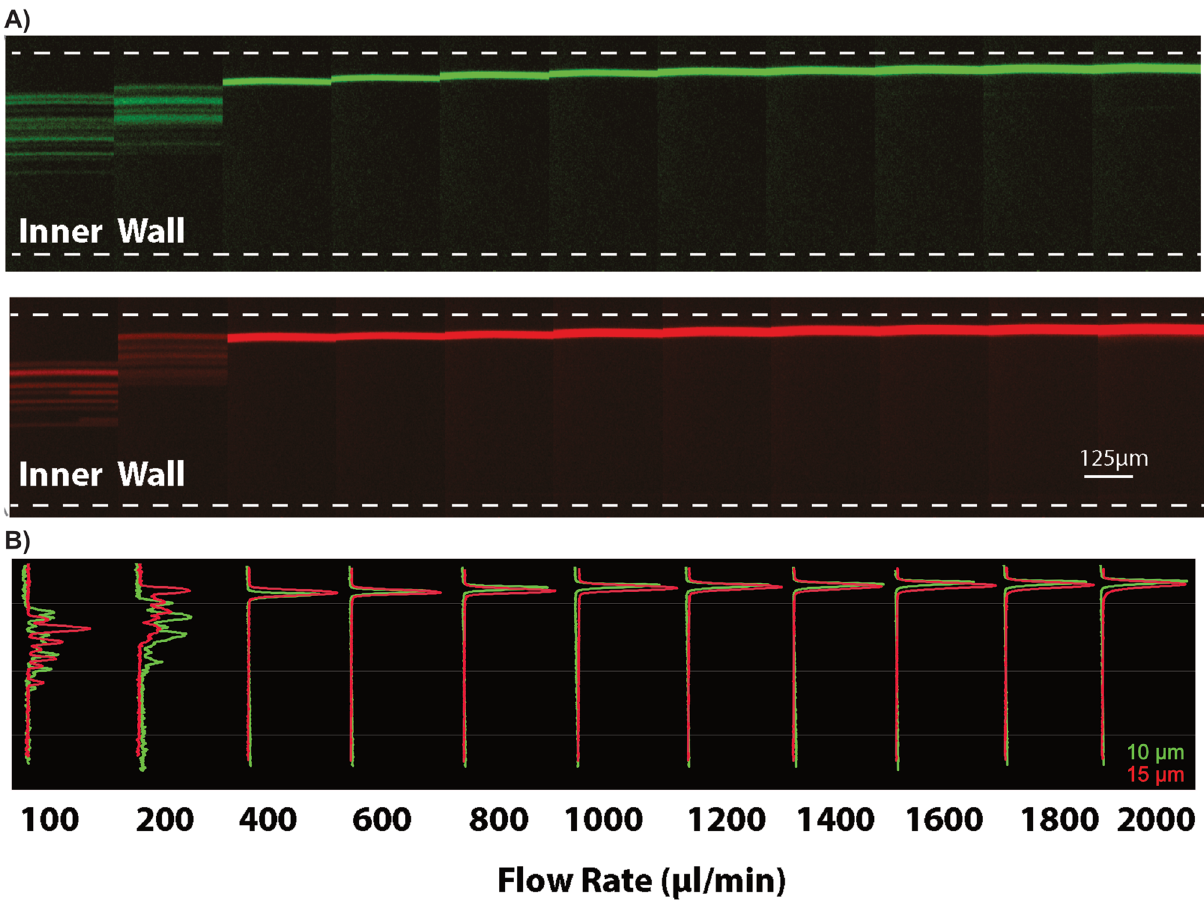
Figure 3. Particle focusing (forward flow direction). ( A ) Fluorescence image of 10 (green) and 15 µm (red) particles at the 10th turn of the spiral for different flow rates. Stable particle focusing obtained at the outer wall of the spiral microchannel for flow rates of 400 µl/min and above. Scale bar: 125 µm. ( B ) Corresponding overlapped cross-sectional intensity of the 10 and 15 µm particles. At low flow rates, the particles are unfocused and spread. As the flow rate is increased, the particles are focused and remain focused even at extremely high flow rates (2 geometries (for a = 10 µm) at different flow rates are shown in Figure S1B in the ESI. The flow direction is defined from center position (r = 0 mm) as forward and from the outer position (r = 15 mm) as backward flow. Initially, flow from the outer position (backward) was used to evaluate particle focusing at turn 5 (r = 7 mm) for a range of flow rates (Fig. 2). As can be seen in Fig. 2, at low flow rate (100–200 µl/min), although unfocused, the 10 and 15 µm particles start to migrate towards the outer half of the channel width. As the flow rate increases, both par- ticles are clearly focused at the outer wall of the channel. The larger 15 µm particles are initially focused closer to the outer wall compared to the smaller 10 µm particles. However, as the flow rate increases (> 800 µl/min), both particle sizes are fully focused on the same lateral position. As the flow rate increases further the particles start to defocus. The transition is more pronounced for the 10 µm particles, as the particles migrate from a single stream to multiple streams away from the outer wall (at flow rate 1.8–2 ml/min). Next, flow in the forward direction was evaluated by observing particle behavior at the outlet (turn 10) (Fig. 3). Initially, the particles were spread and remained unfocused at low flow rate of 100 µl/min (Re < 2), presumably due to insufficient lift and Dean forces. As the flow rate increases both particles are focused at the outer wall. Importantly, the 10 and 15 µm particles are focused at the same lateral position and remain focused even at extremely high flow rate (2 ml/min, corresponding Re = 67 for 10 µm particles).